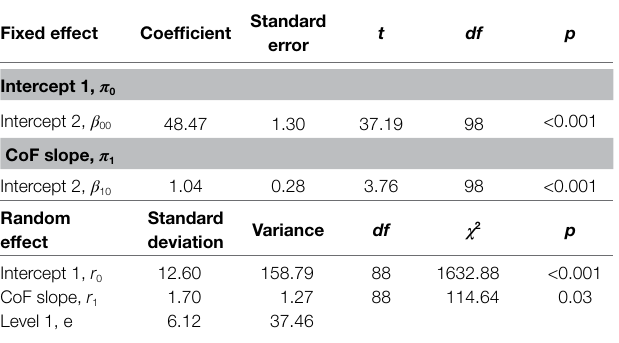
TABLE 6 | Effects of COVID-19-related restrictions and concerns on committed action.